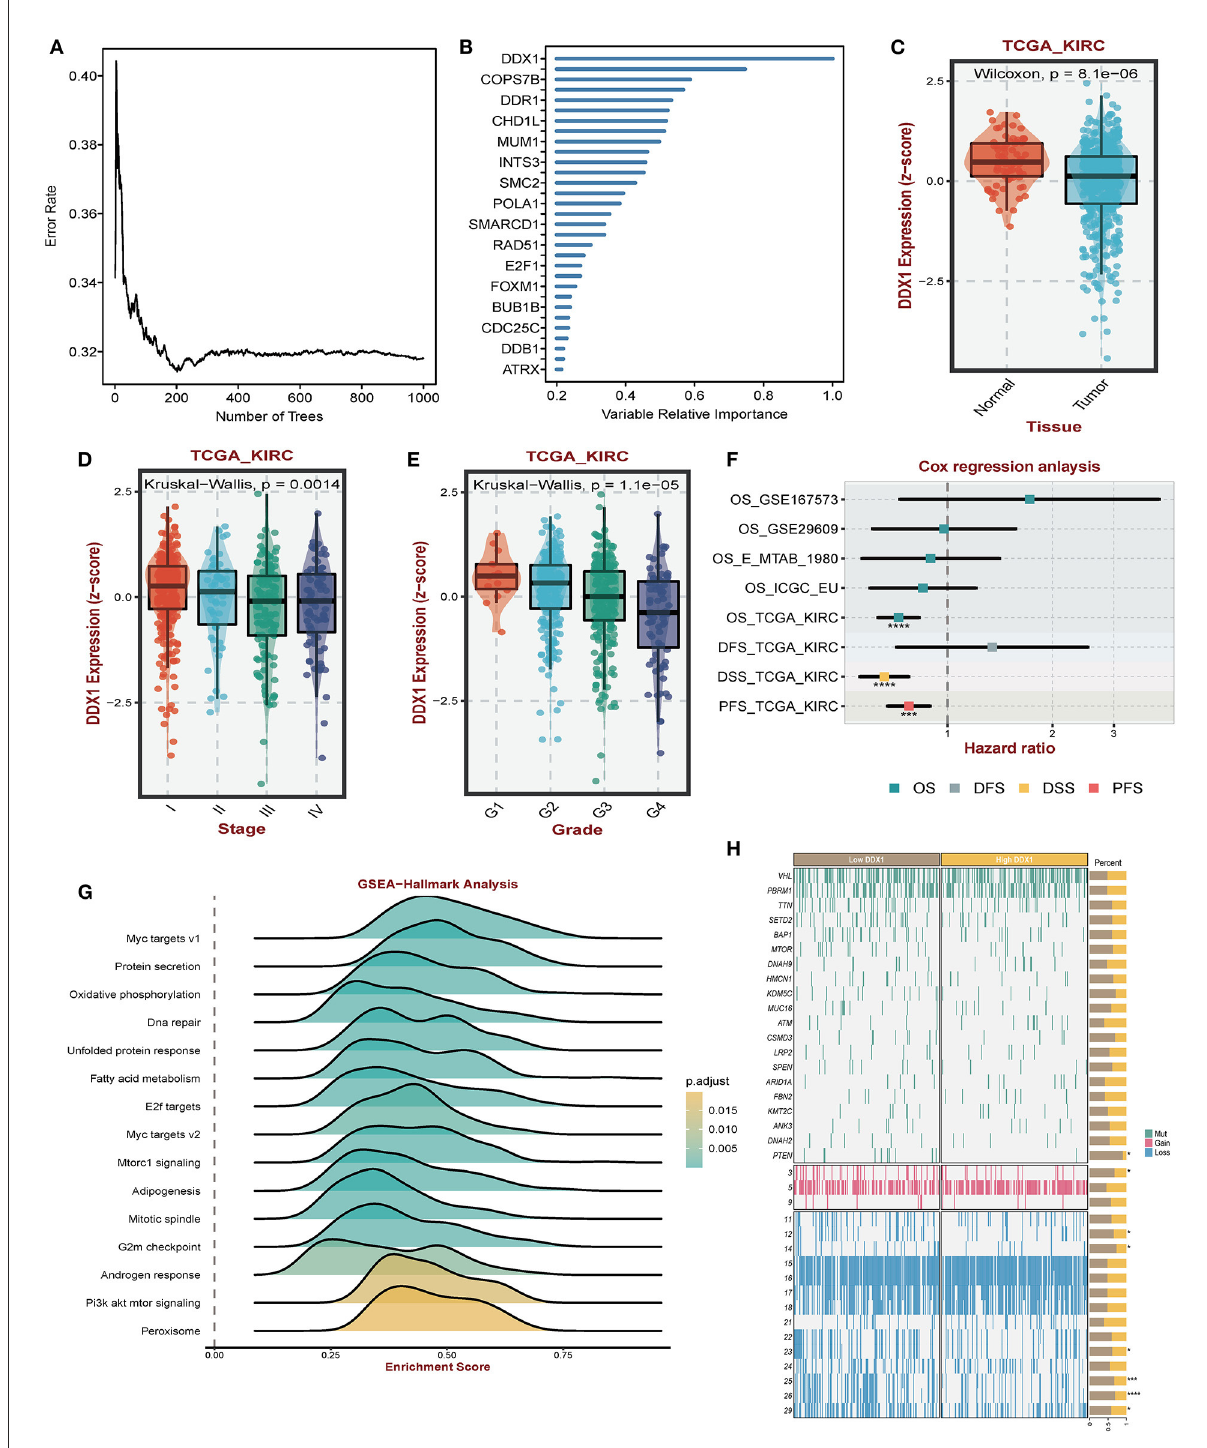
FIGURE8 Impact of DDX1 in ccRCC. (A,B) Radom Forest tree indicating the importance of DDR-related signatures. (C) Different expression level of DDX1 in normal and tumor tissues. (D,E) Expression level of DDX1 in different stage and grade tumor tissues. (F) Survival impact of DDX1 in ccRCC across different datasets. (G) GSEA-hallmark analysis based on DDX1 expression level in ccRCC. (H) Mutation and genomic landscape between DDX1 low and DD1 low groups in